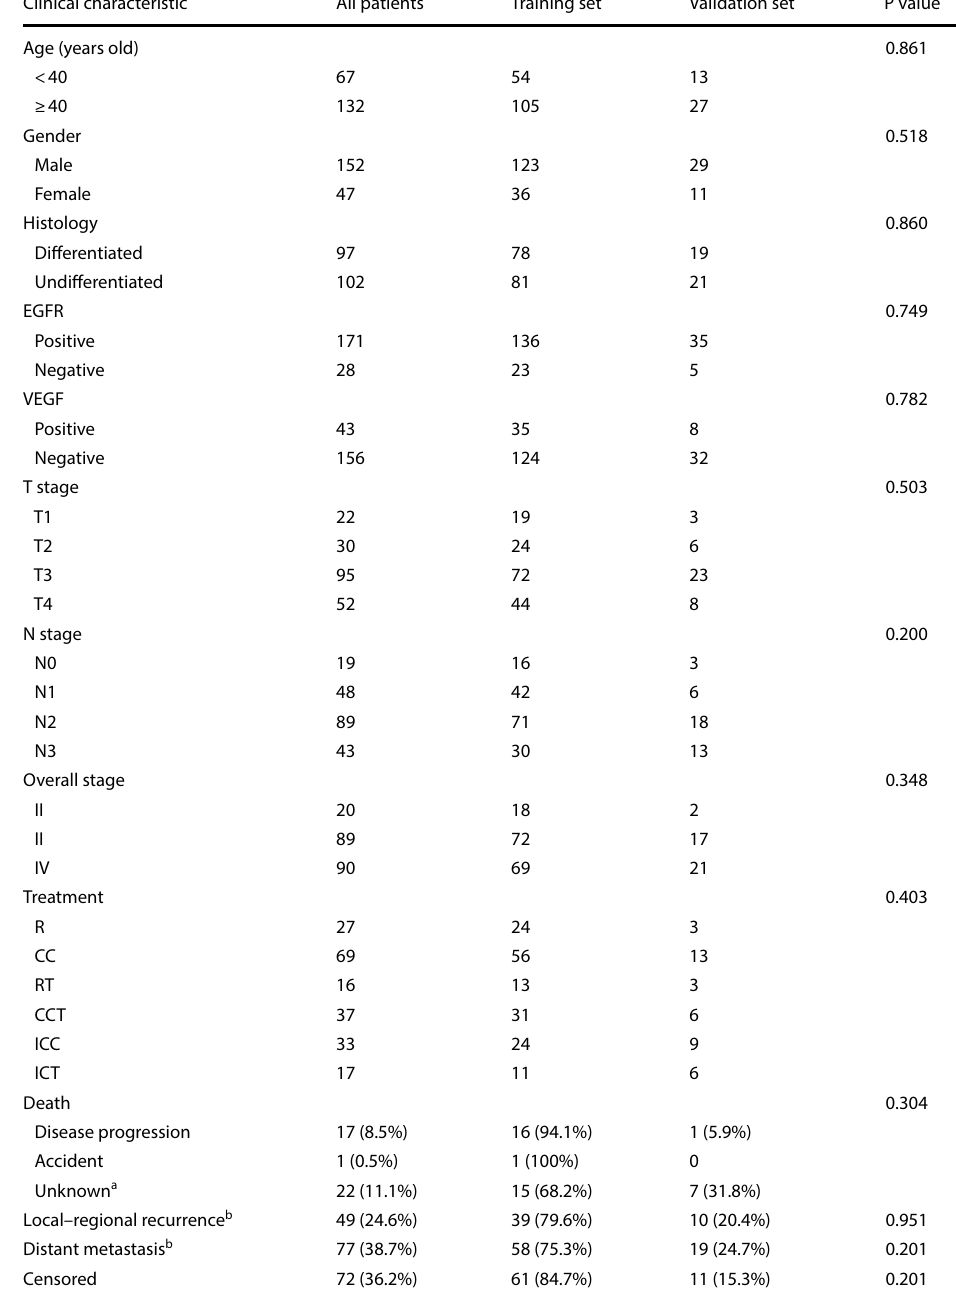
Table 1 Baseline clinical characteristics of the